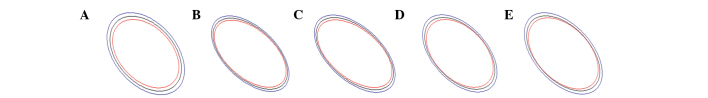
Tensor uncertainties prior to and following various denoising methods. The mean value is denoted in black and the 95% confidence interval is denoted in red and blue. Tensor uncertainty after (A) 5% Rician noise corruption, and denoising with (B) RD, (C) LED and (D) ED weighting and (E) UNLM in DWI space. RD, Riemannian distance; LED, Log-Euclidean distance; ED, Euclidean distance; UNLM, unbiased non-local mean; DWI, diffusion-weighted image.